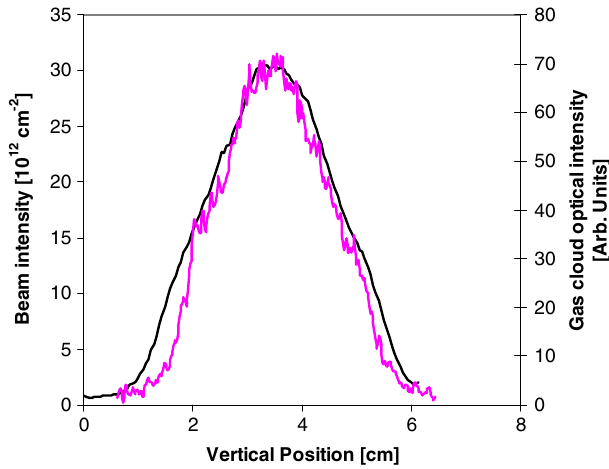
FIG. 13. (Color) Comparison between beam intensity integrated along the horizontal direction (black) of the beam of Fig. 2, and the optical emission from the gas cloud integrated along the horizontal direction (magenta) of the gas cloud at the end of the beam pulse (Fig. 6), both plotted with respect to vertical